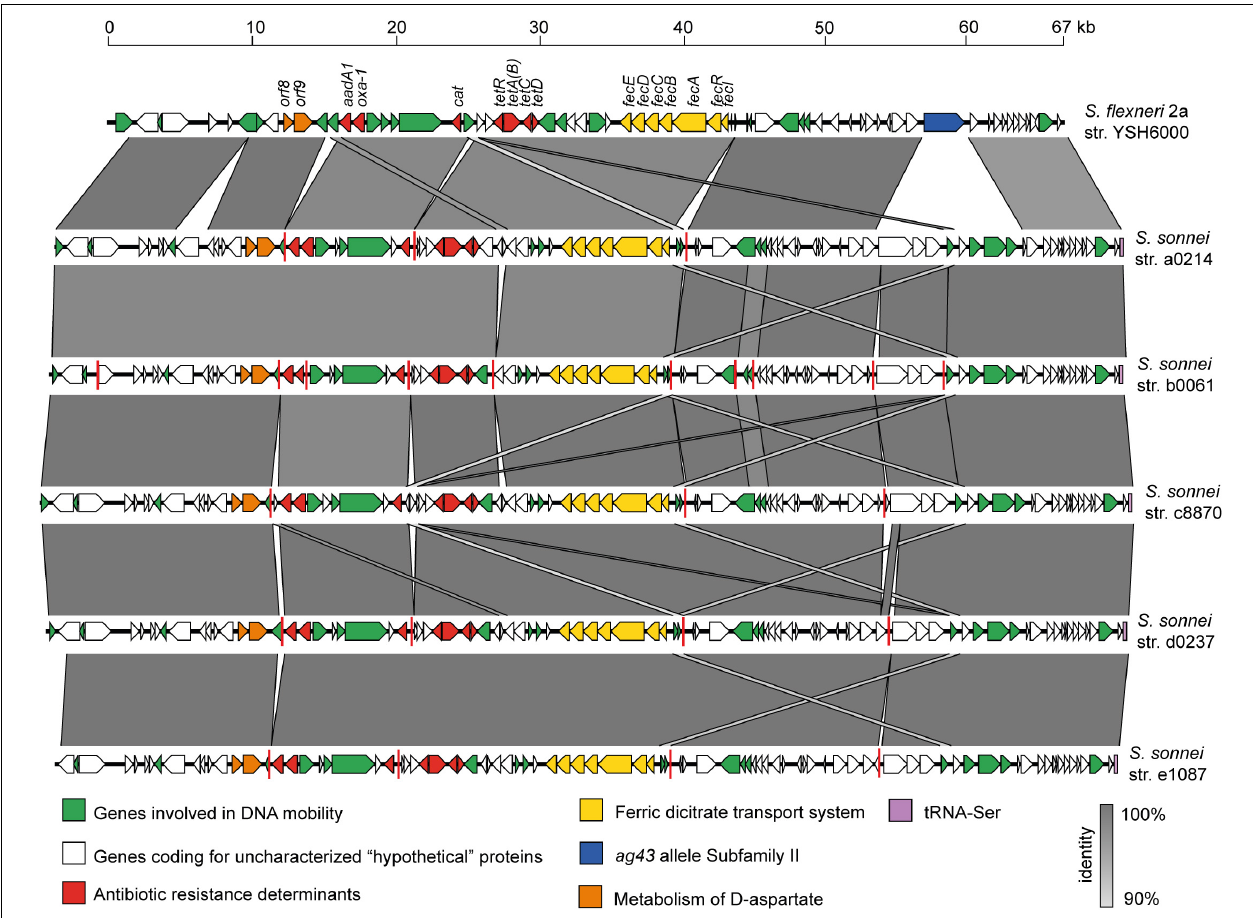
FIGURE 6 | Comparison of the genetic structure of SRL pathogenicity islands carried by the Shigella flexneri 2a YSH6000 strain and Chilean S. sonnei strains. The predicted genes and the direction of transcription are represented as block arrows. The genes are color-coded according to gene function, as indicated in the legends at the bottom. The names of some genes are indicated. The conserved regions are shaded in gray, and the intensity of the color indicates the nucleotide identity levels, from 88 to 100%. Contig boundaries are shown as red lines. The GenBank accession numbers are indicated in Table 2 . The figure was prepared using EasyFig (Sullivan et al.,